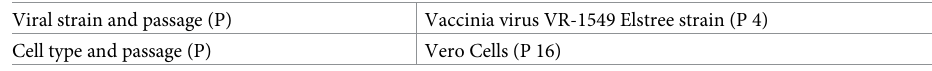
Table 3. Experimental